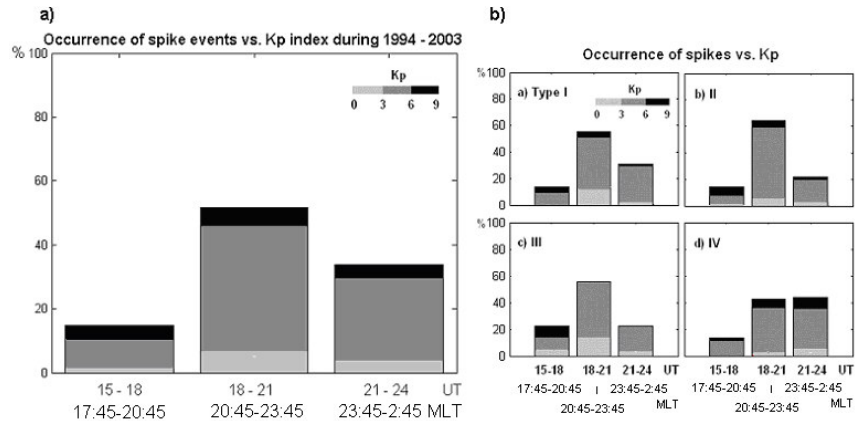
Fig. 5. (a) Dependence of spikes on the K p index. Colorbars represent the occurrence of spikes during 3-hour time sectors versus 3 levels of K p index.(light grey for events occurred during K p smaller than 3, dark grey for events occurred during K p between 3 and smaller than 6 and black for events occurred during K p between 6 and 9). (b) Occurrence of 4 types of spikes versus K p index is shown with similar